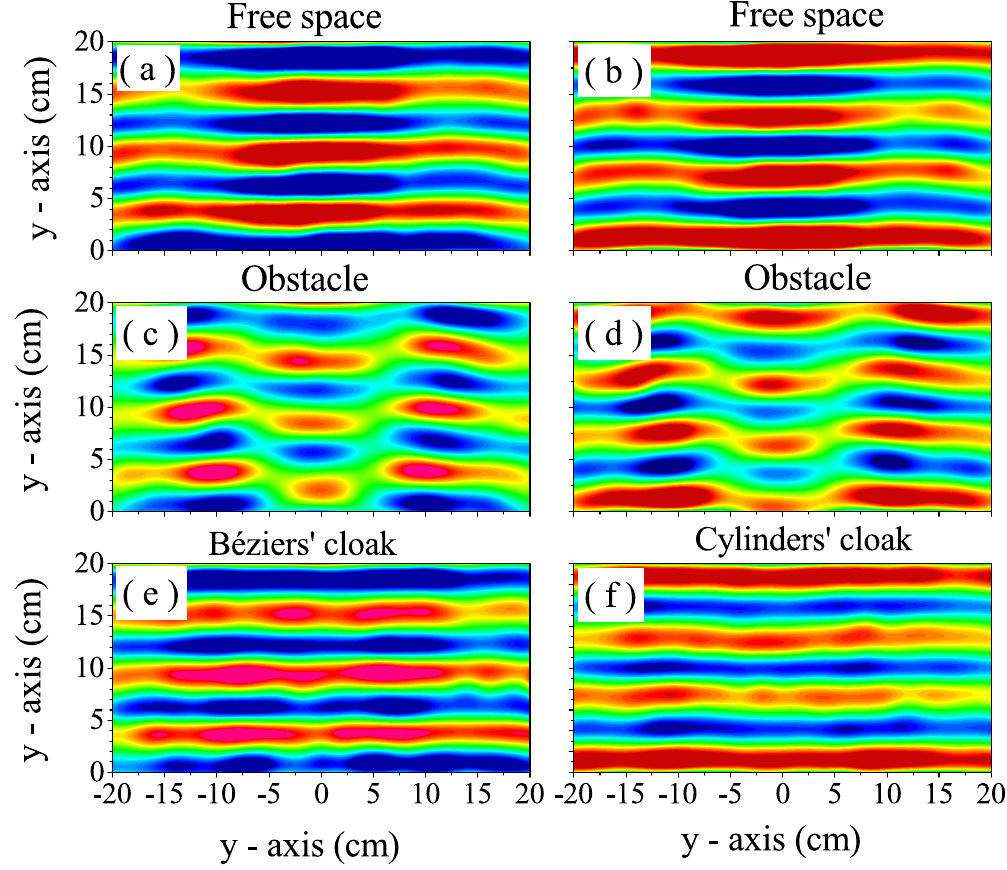
Figure 6. Total pressure maps (real part) measured at 5940 Hz (left panels) and 6080 Hz (right panels). ( a ) and ( b ) represent the maps obtained when the waveguide is empty (free space). ( c ) and ( d ) show the maps obtained with the obstacle inserted in the waveguide. Finally, ( e ) and ( f ) plot the maps resulting from the designed cloaks surrounding the obstacle. Both cloaks practically recover the plane wavefronts depicted in ( a ) and ( b ),